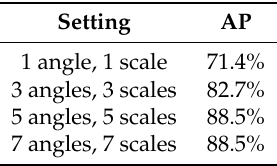
Table 3. The AP for different settings of generating anchors.